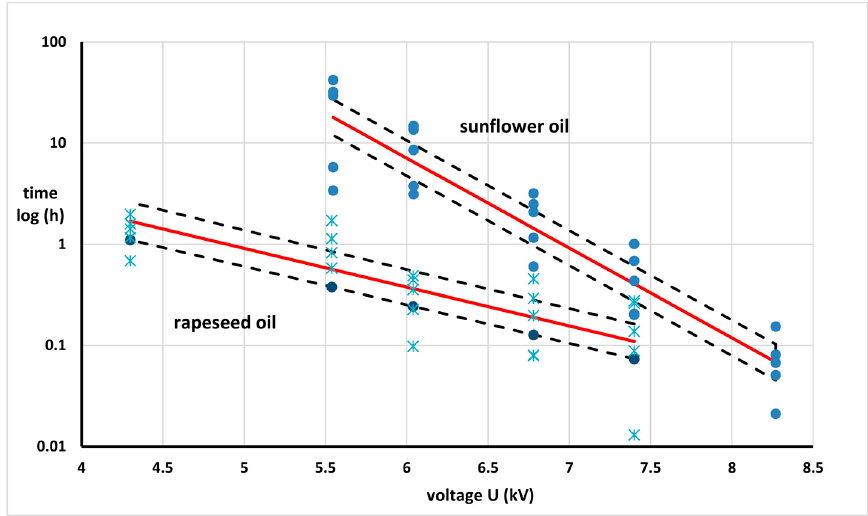
Figure 2. Time to breakdown characteristics for voltage stress exposition.